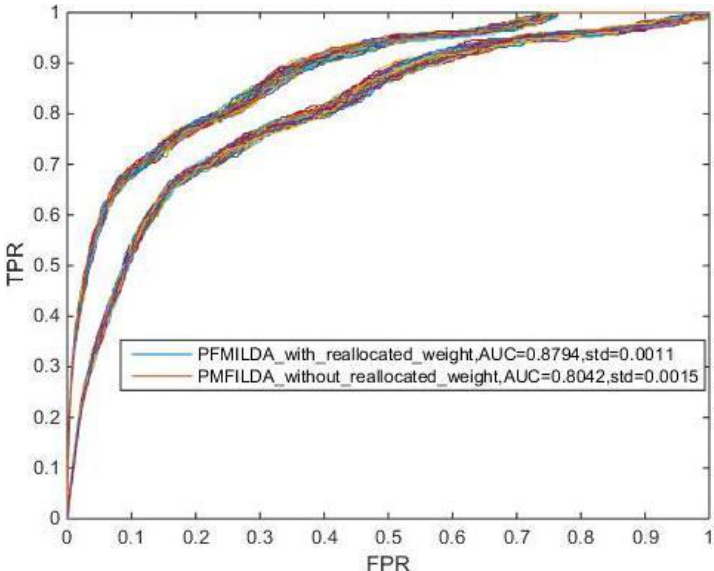
Figure 9. AUCs achieved by PMFILDA in LOOCV while the weight of G LDMN was reallocated or not reallocated